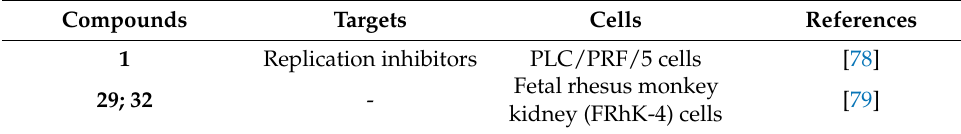
Table 4. Summary of anti-HAV triterpenoids and their targets and